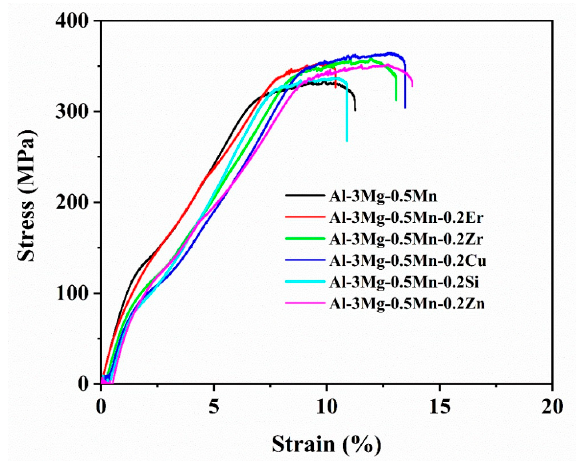
Metals 2020 , 10 , 483